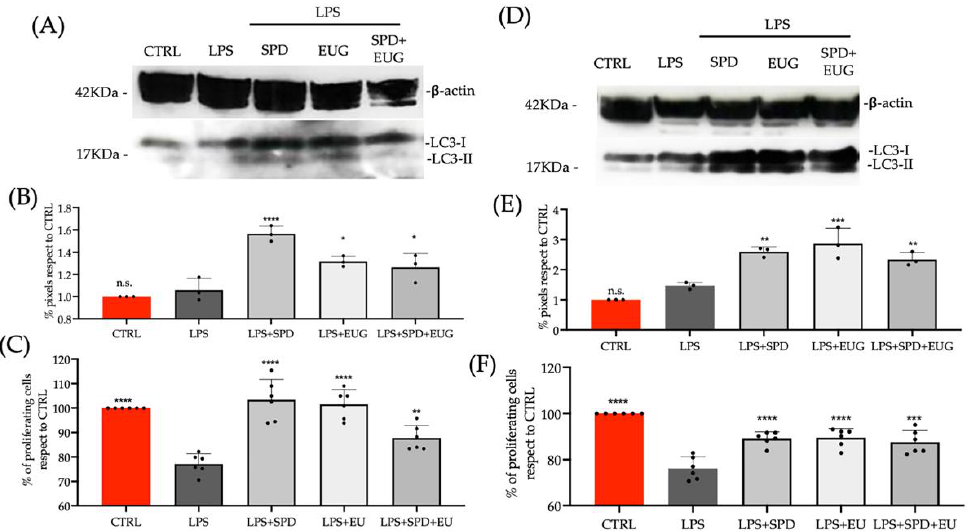
Figure 7. The effect of a 1 h pretreatment with 0.3 mM spermidine (SPD) and 0.2 mM eugenol (EUG), alone and in combination (0.1 mM SPD + 0.05 mM EUG), before the administration of lipopolysaccharide (LPS, 1ng/mL) to Caco-2 cells ( A – C ) and L929 cells ( D – F ) for 24 h ( A , D ). Treatments were compared with the untreated control and LPS treatment alone. Western blotting of LC3-II with respect to β -actin was performed on Caco-2 cells ( A ) and L929 cells ( D ) that were untreated or treated with LPS + SPD, LPS + EUG and LPS + SPD + EUG and the pixels quantified ( B , E ). Cell viability using the MTT assay on the Caco-2 ( C ) and L929 ( F ) cell lines. The number of stars *, **, *** and **** represents significant differences between treatments as determined by one-way ANOVA at the 99% confidence level ( p < 0.01), whereas n.s. is not significant. The black dots indicate the positioning of the individual replicates within the bar for each